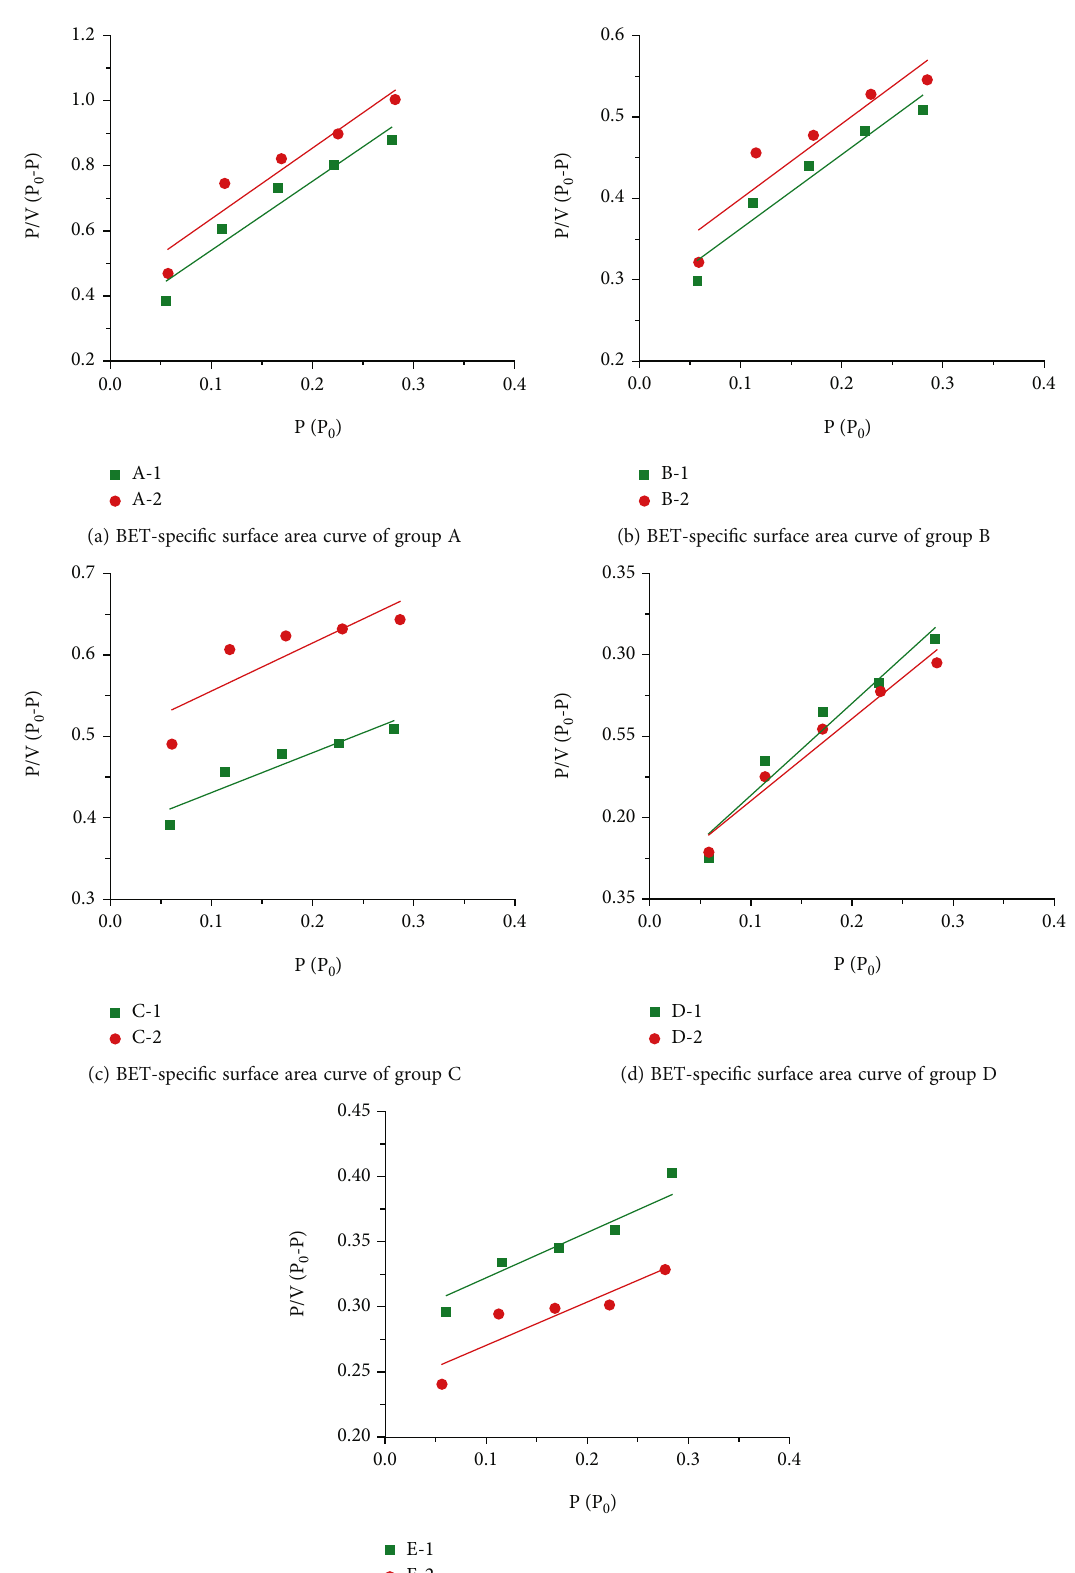
(e) BET-speci fi c surface area curve of group E Figure 13: BET-speci fi c surface area curve of gypsum rock